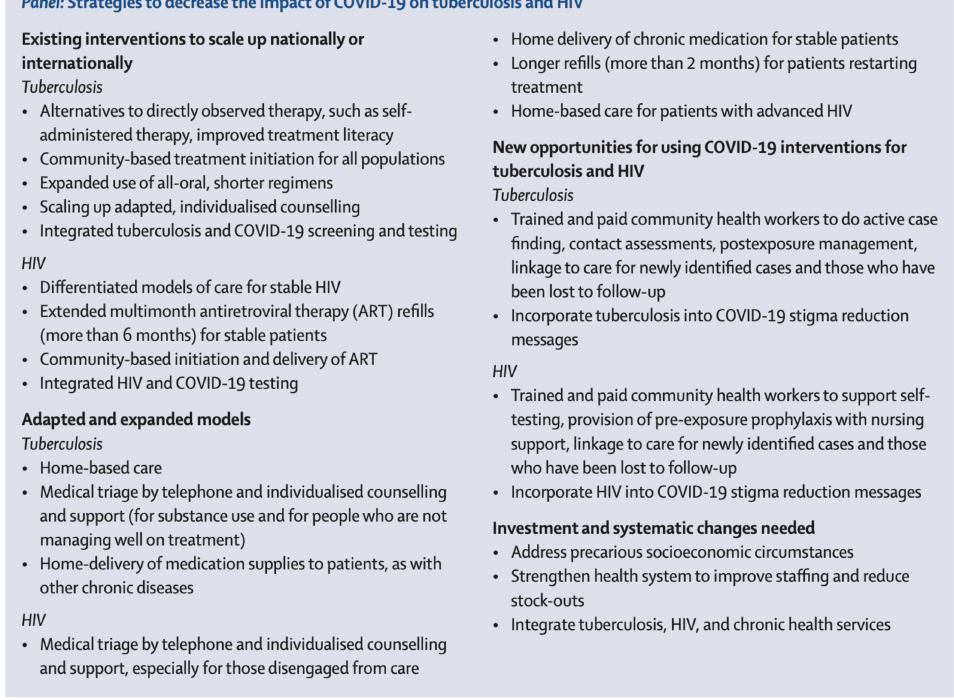
Figure 3. Strategies to decrease the impact of COVID-19 on tuberculosis and HIV in South Africa (Source: